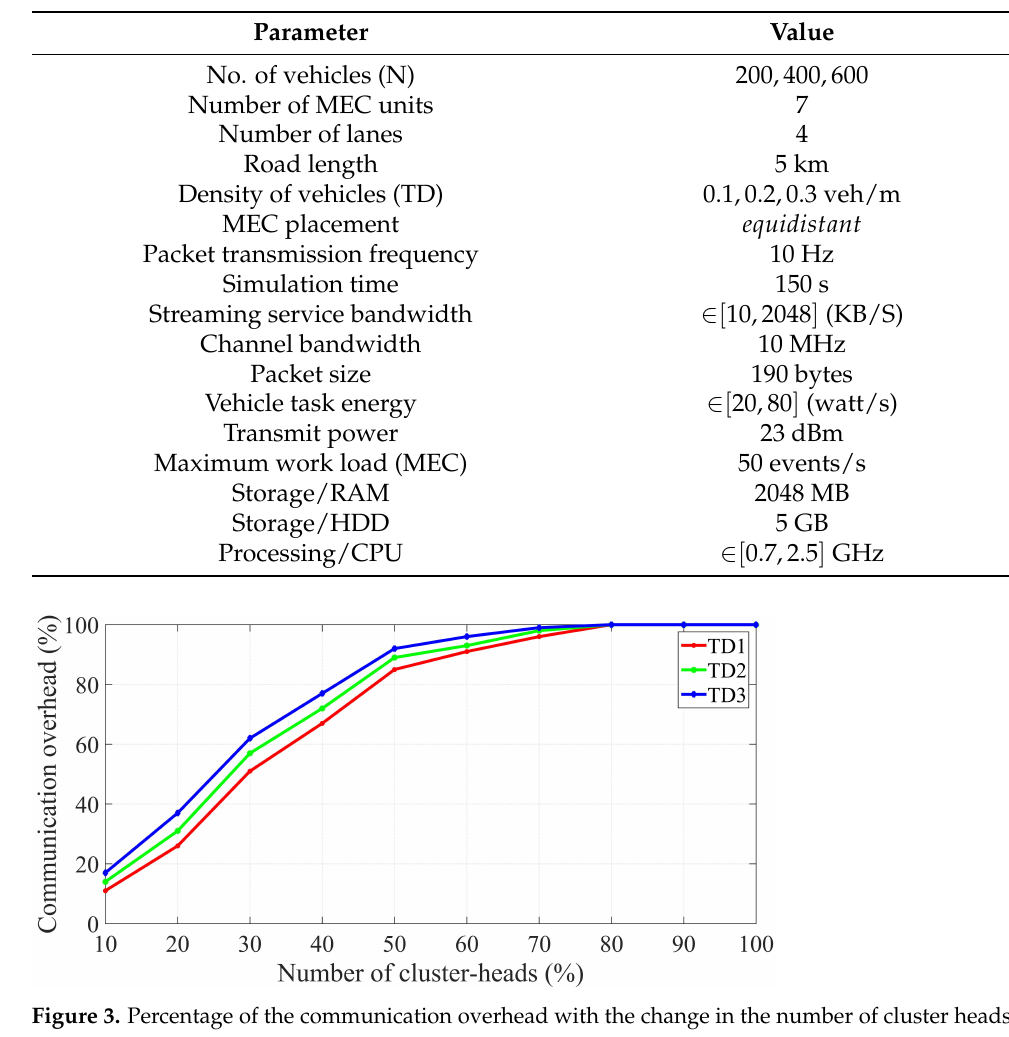
Table 2. Simulation parameters.